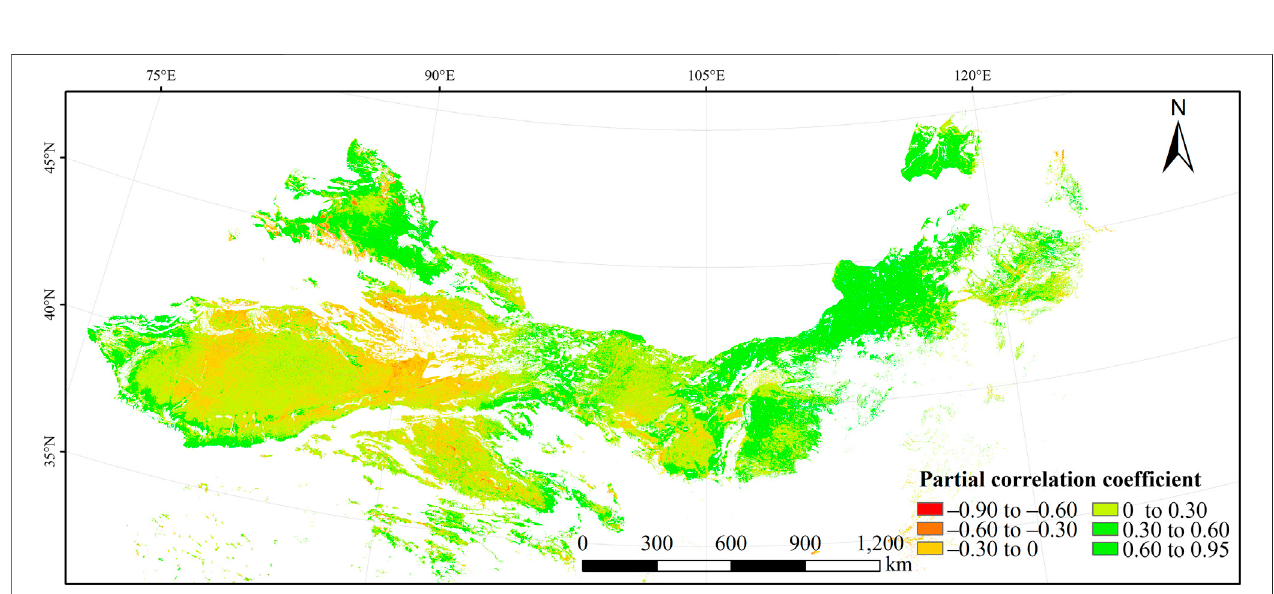
FIGURE8| Spatial distribution ofpartialcorrelationsbetweenthemulti-yearmeannormalized-differencevegetationindex (NDVI) from1998to2015andthemean total annual precipitation for the same period in the desert area of northern China.